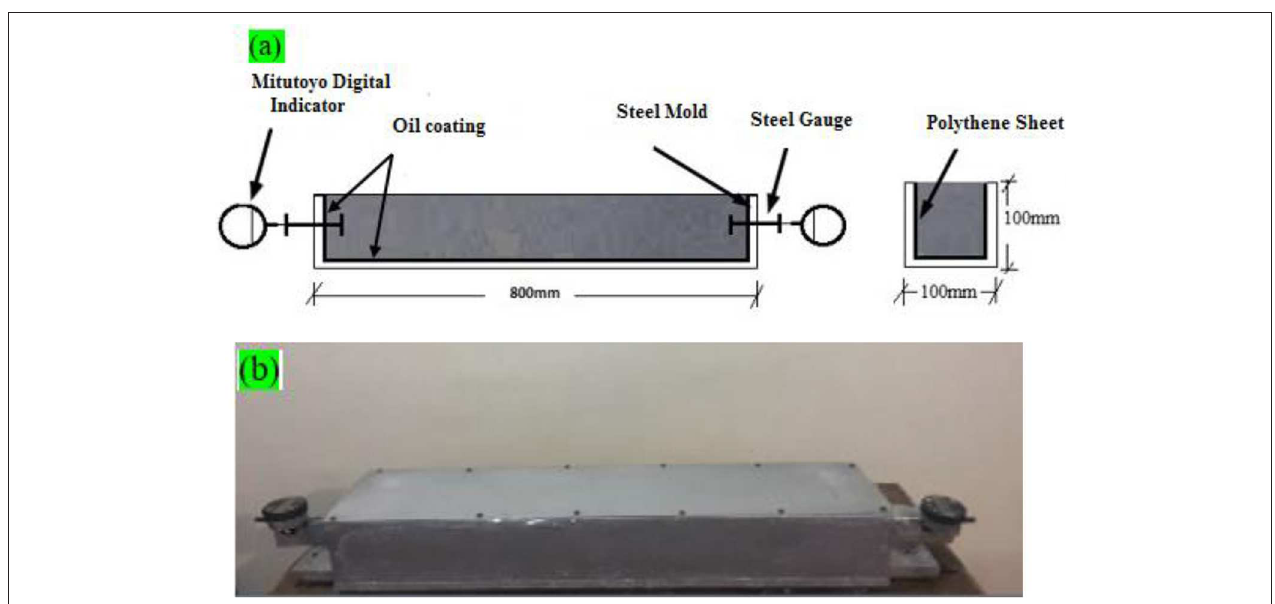
FIGURE 7 | (a) Schematic to measure autogenous shrinkage in concrete, (b) Experimental set up to measure linear autogenous shrinkage in concrete with and without RHA.